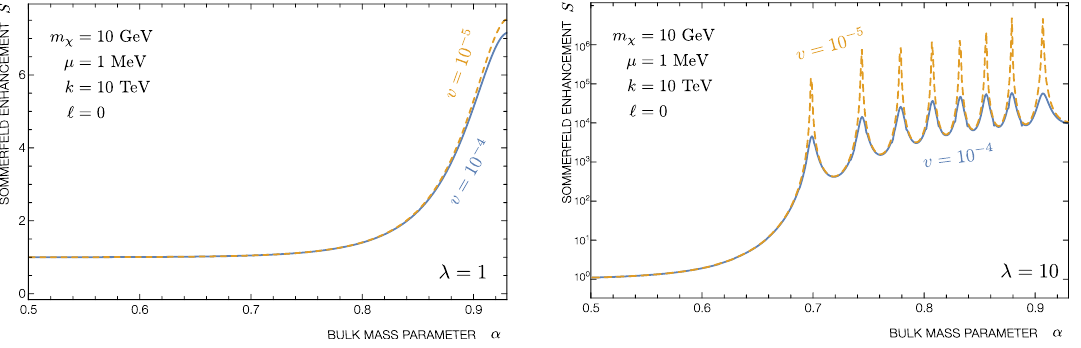
. For example for µ/m = 10 − 4 we find S ∼ 10 χ χ